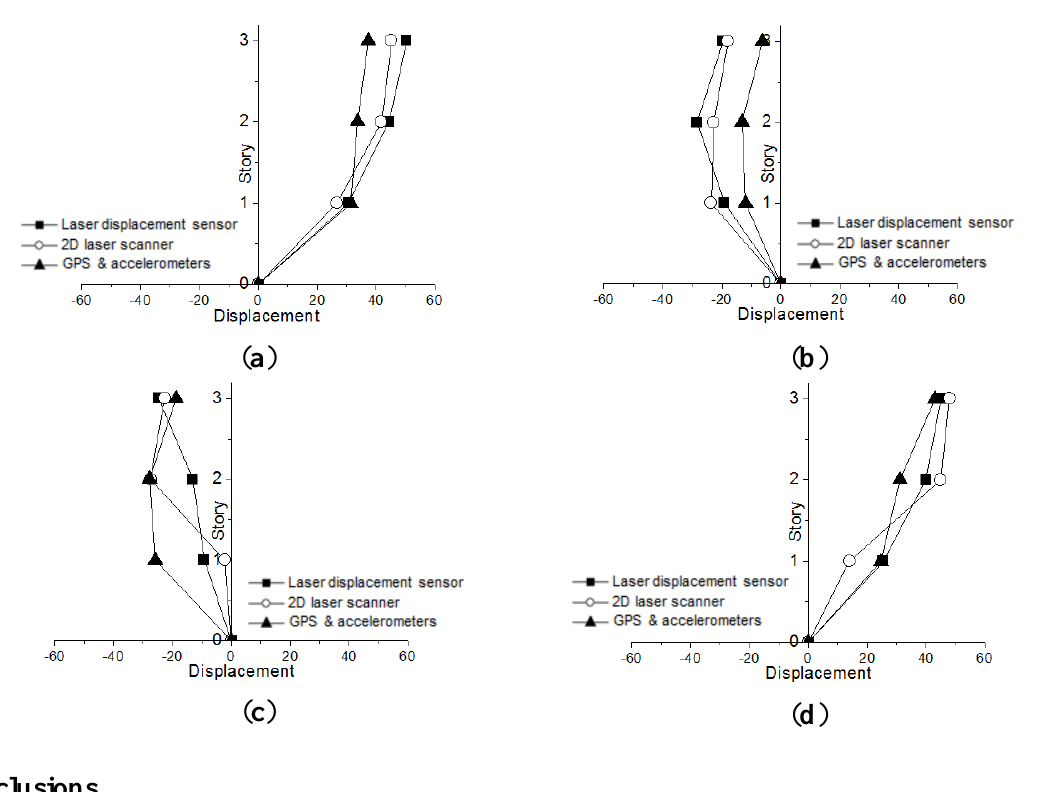
Figure 11. Deformed shapes from three different methods at a discrete